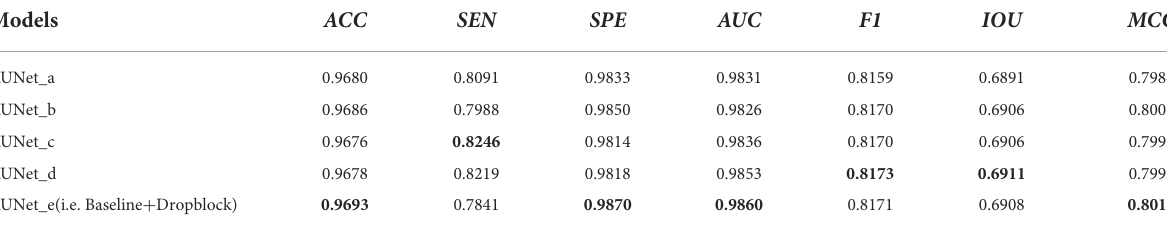
TABLE 4 Comparative experiments of different residual blocks on DRIVE dataset.